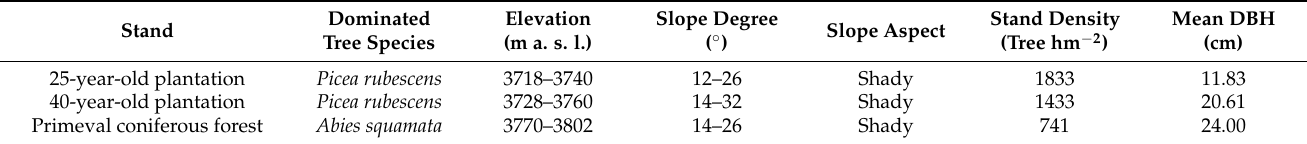
Table 1. Basic characteristics of the three different